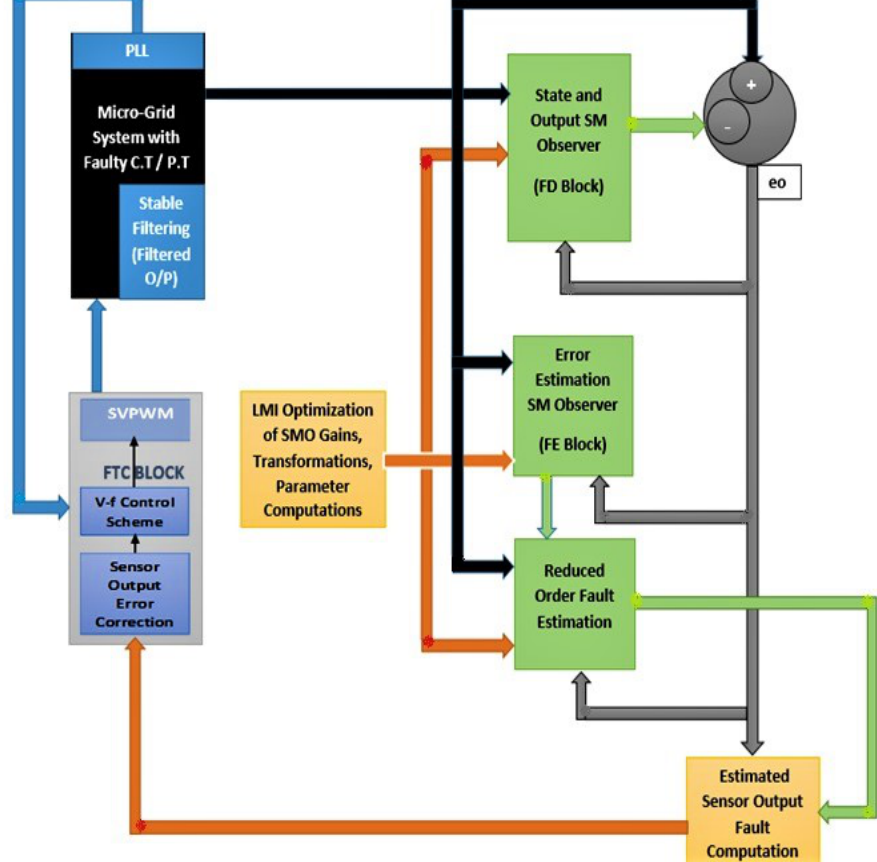
Figure 1. Sensor (C.T/P.T) fault diagnosis and fault-tolerant control